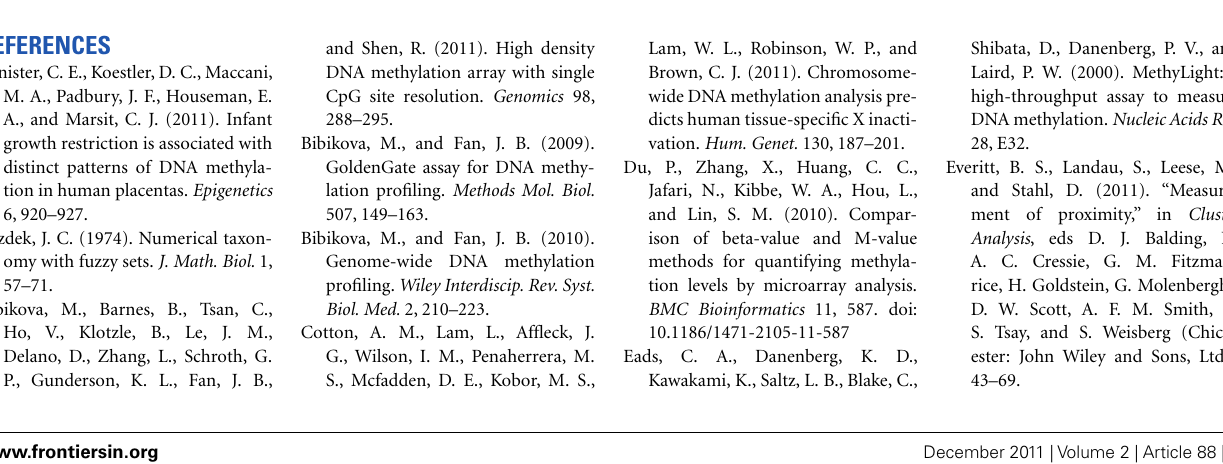
FIGURE 6 | Box plots of adjusted Rand index for the top ranking method (as determined by silhouette width rank) for 1000 replicates of each simulation (S1–S15). For each figure the solid horizontal line represents the median rand index, the box contains the interquartile